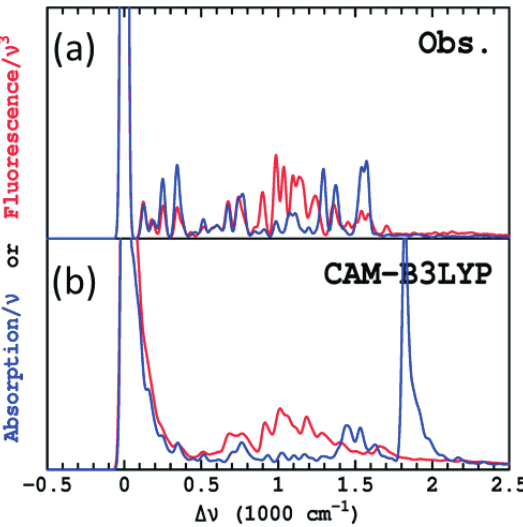
Fig. 10. Observed (in TEA at 4.5 K) and calculated (CAM-B3LYP, gas phase) high-resolution spectra, depicting absorption (blue) and reflected emission (red) for Pheo-a [122]. Both observed and calculated spectra are slightly broadened to avoid accidental resonance